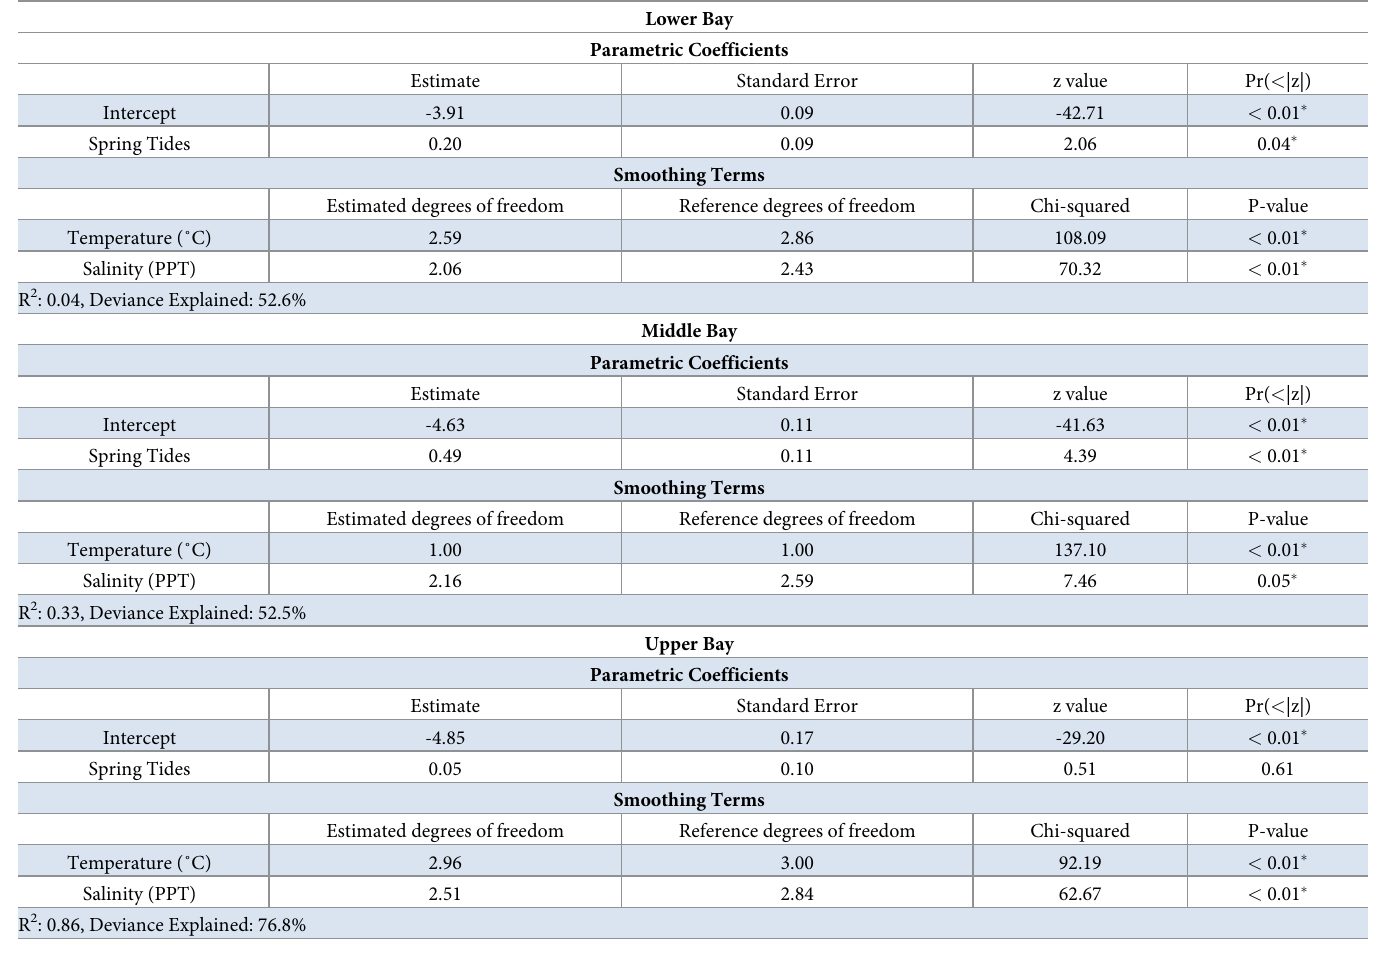
Table 2. Results from the generalized additive model